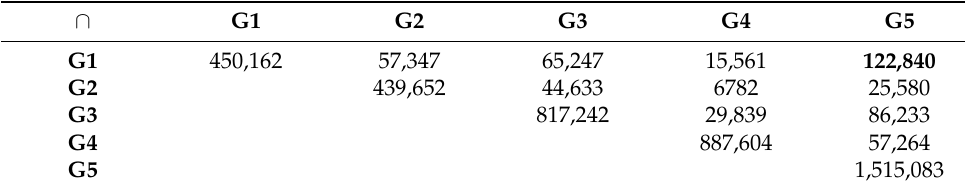
Table 3. Intersection of the lists among the groups.